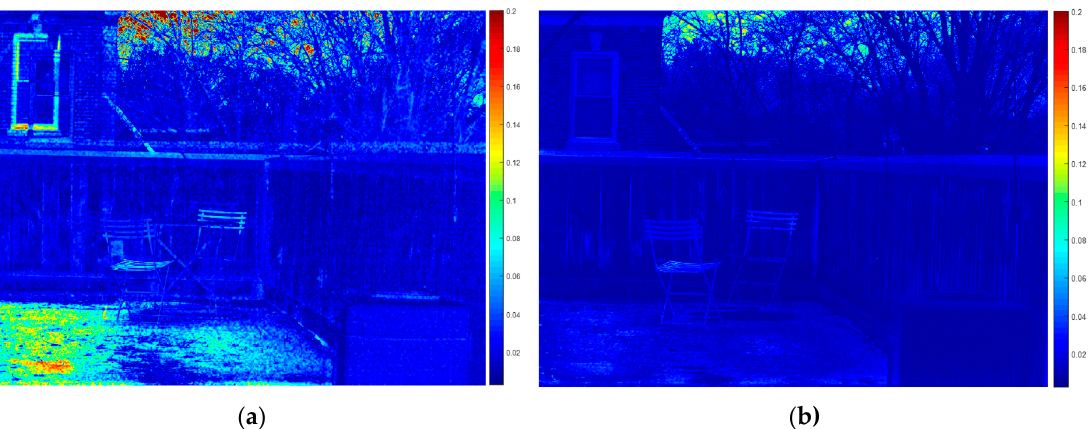
Figure 4. Example of a per-pixel RMSE (root–mean–square error) image from the Harvard dataset [34]: ( a ) Image where translation is applied by cutting off and ( b ) an image in which the histogram is not matched with that of an RGB image.